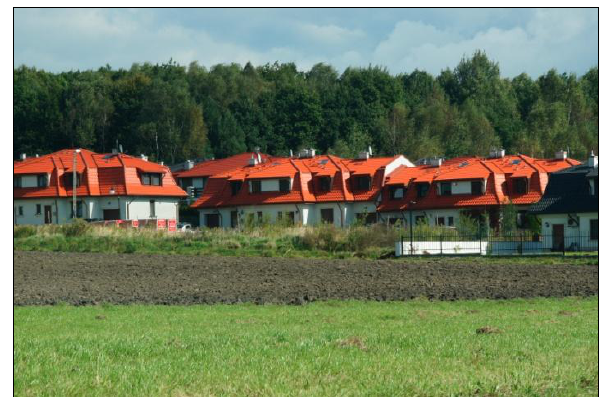
Fig. 8. Detached housing development in Ruda Śląska ( K. Mazurek